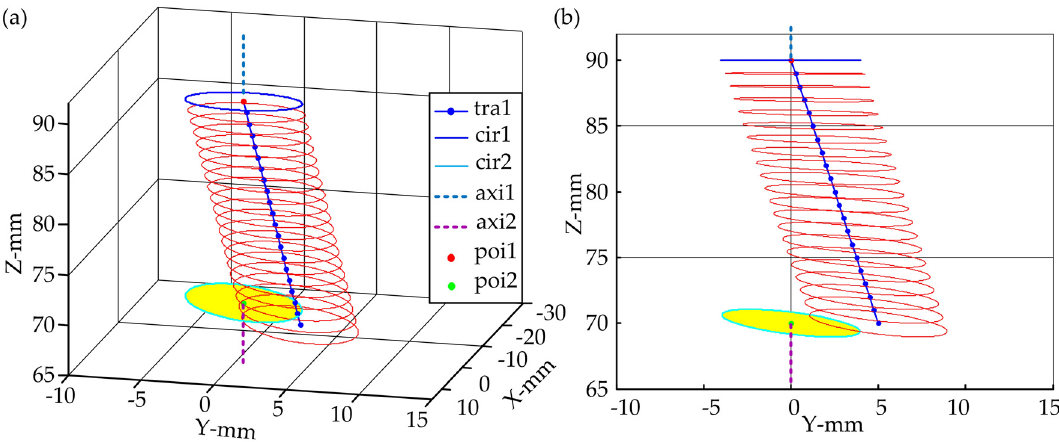
Figure 8. ( a ) The shape and trajectory of the bone with joint adjustment for equal bone distraction. ( b ) The view in the Y–Z plane.